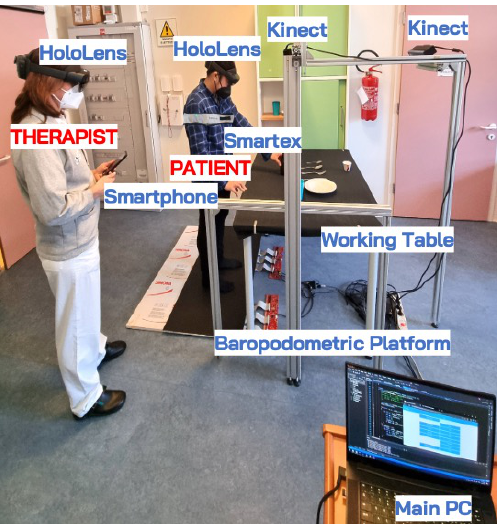
Figure 1. Framework setup in the AUSILIA